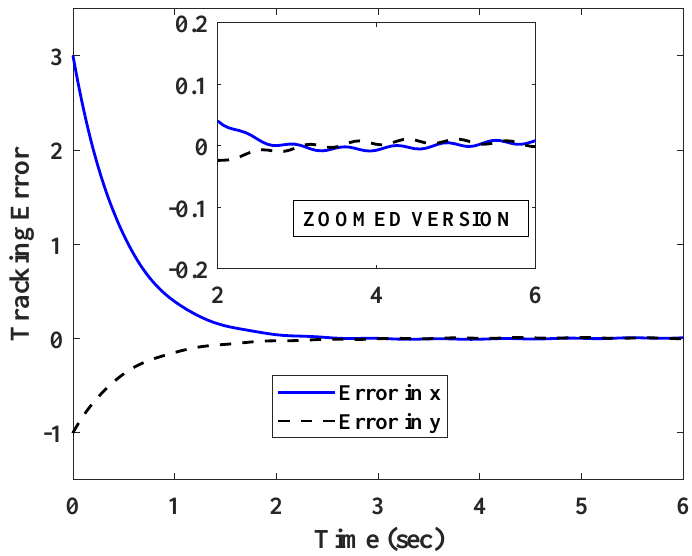
Figure 8. Convergence of X and Y position of robot in presence of fast varying measurement